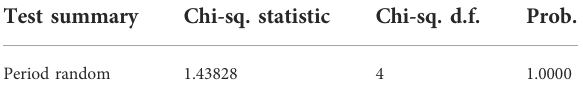
TABLE 6 Correlated random effects: Hausman